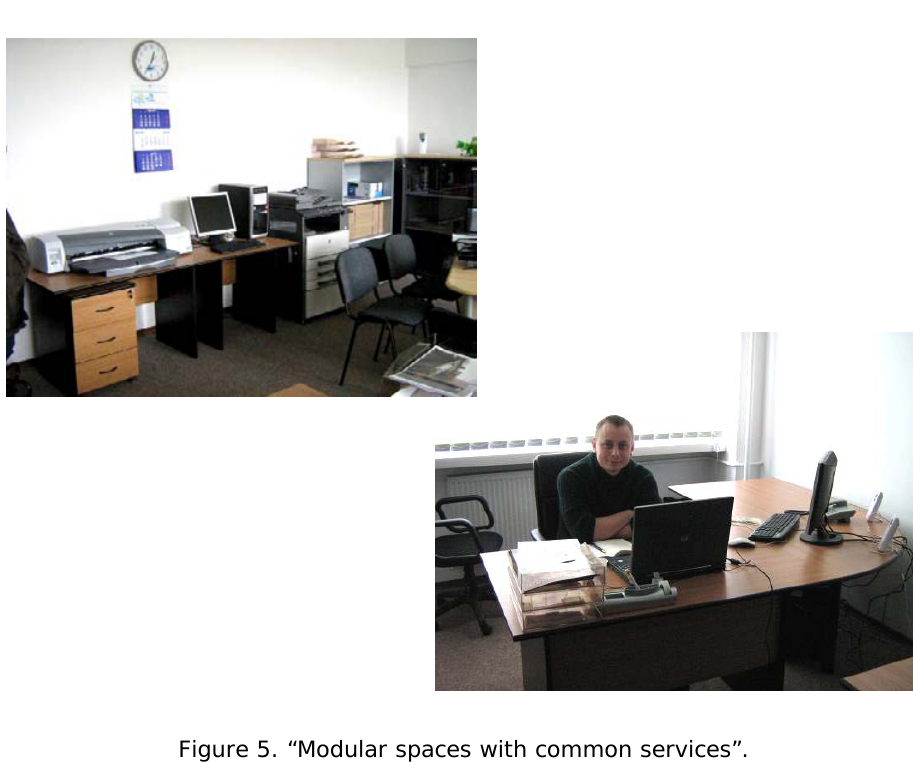
Figure 5. “Modular spaces with common services”.